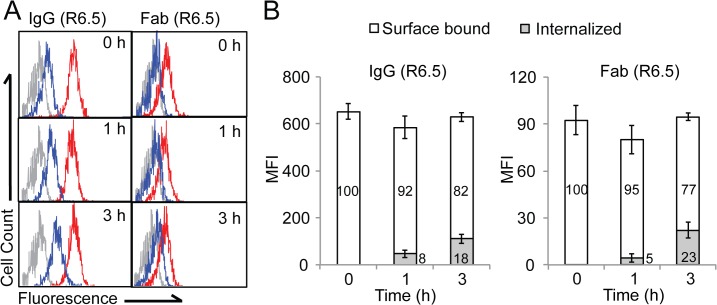

In vitro assays to confirm ICAM-1 specific internalization.(A) Flow cytometry histograms are shown for HeLa cells labeled with Alexa488-conjugated R6.5 IgG or Fab with (histograms in blue line) or without (histograms in red line) additional incubation with anti-Alexa488 antibody. 0, 1, 3 h indicate the time of incubation at 37°C after labeling with Alexa488-conjugated R6.5 IgG or Fab. Background fluorescence is shown in a histogram in gray. (B) Quantification of fractions internalized and surface bound is shown for R6.5 IgG and Fab in bar graphs as mean ± SEM (n = 3). The numbers represent the percentage values.